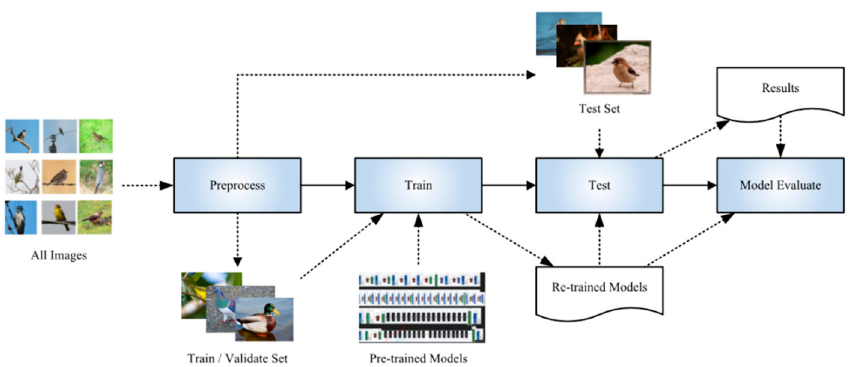
Figure 3. Pipeline of our proposed framework for identifying habitat elements.